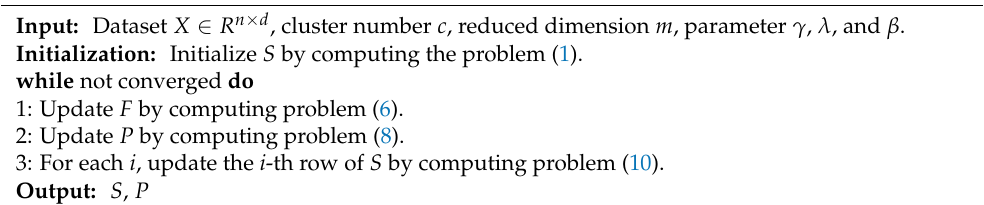
Algorithm 1 Optimization Algorithm for Solving PCSSCAG